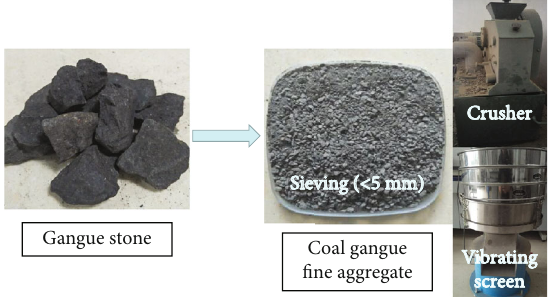
Figure 1: Screening process of coal